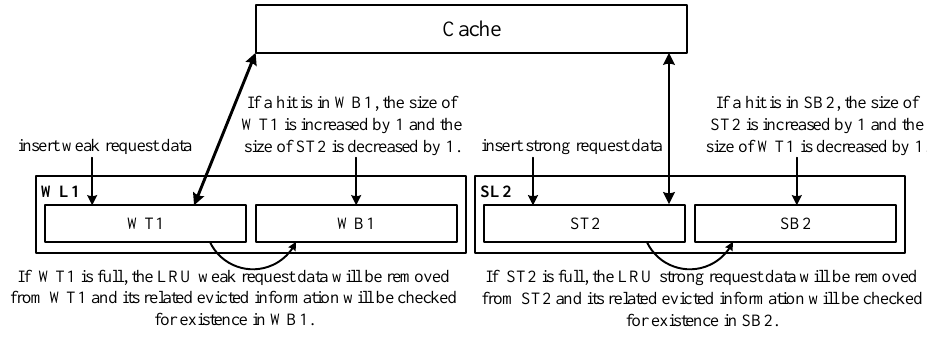
Figure 8. The proposed cache